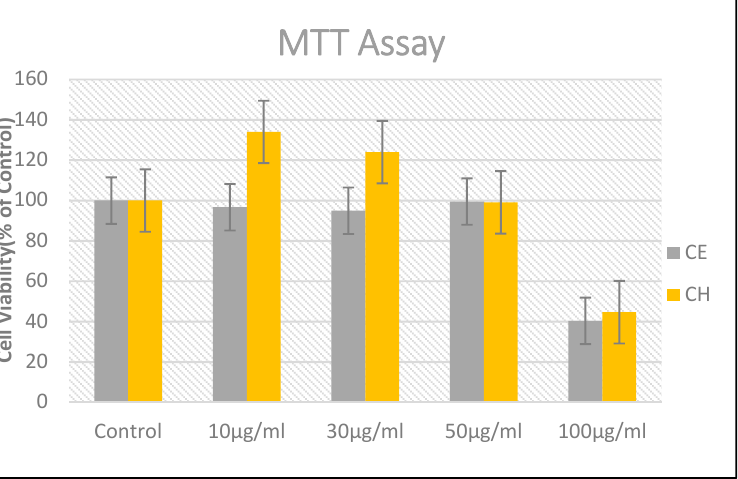
Figure 1. Cytotoxicity assay using different doses (10, 30, 50, and 100 μ g/mL) of Hexanic (CH) and Ethanolic (CE) extracts of C. longa in BuMECs.